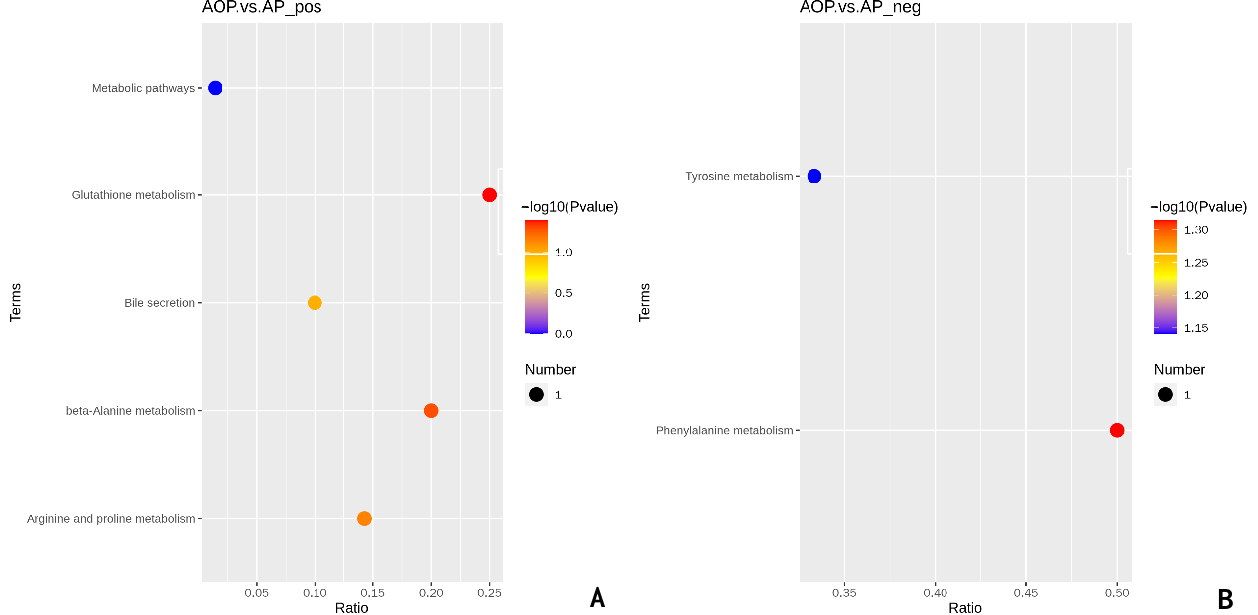
Figure 4. ( A ) KEGG metabolic pathway of AOP vs. AP in positive ion mode; ( B ) KEGG metabolic pathway of AOP vs. AP in negative ion mode. AOP represents the group fed a mixture of oat and alfalfa (n = 5). AP represents the group fed alfalfa (n = 5).